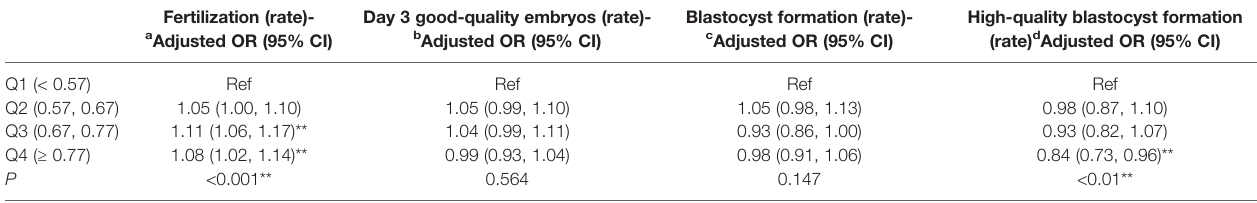
TABLE 4 | Adjusted fertilization, day 3 good-quality embryos, blastocyst formation and high-quality blastocyst (95% CI) by quartile of OS/FP (N = 6110). . Fertilization (rate)- a Adjusted OR (95%